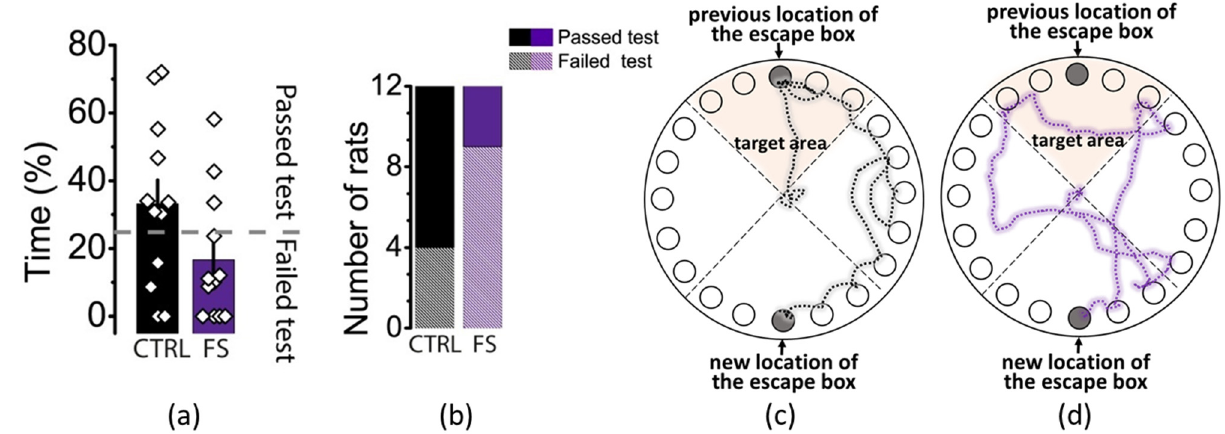
Figure 6. Test day (day 5). ( a ) Percentage of time spent by control (CTRL) and experimental (FS) rats in the target area. Each diamond represents an individual value. ( b ) Diagram showing the number of animals that passed and failed the test. Representative examples of the pathways of a control rat ( c ) and an FS rat ( d ) in the Barnes maze on the test day.